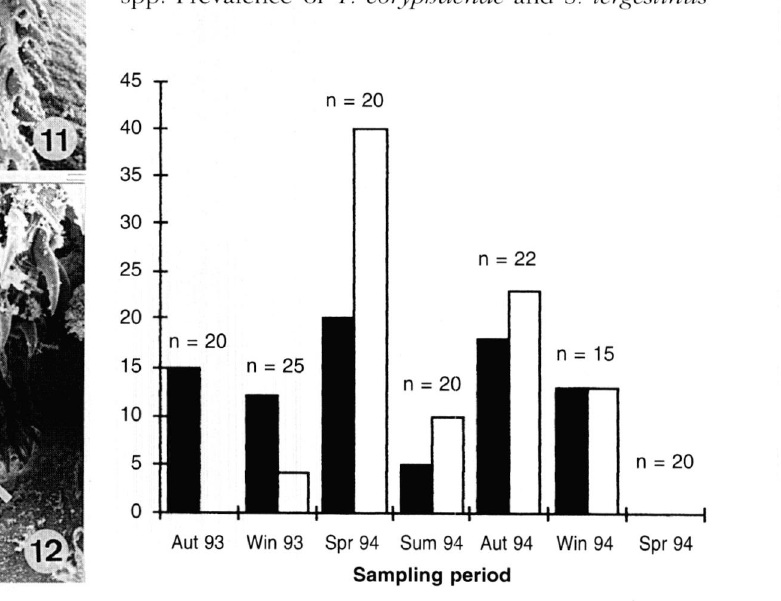
Figs 10-12. - 10: metabasal armature of the tentacle of Sphyrioce phalus tergestinus showing arrangement of hooks (arrows) (bar = 100 µm). 11: view of metabasal armature of two of the tentacles in S. tergestinus and apex of a third tentacle (arrows) (bar - 100 µm). 12: view of basal armature of S. tergestinus (arrow) (bar = 100 µm).